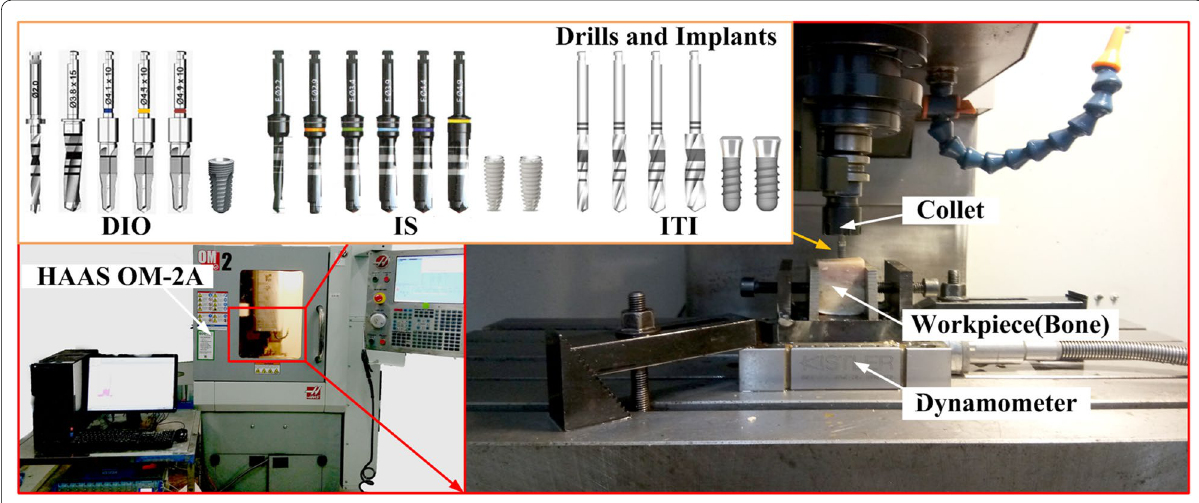
Figure 5 The equipment of insertion